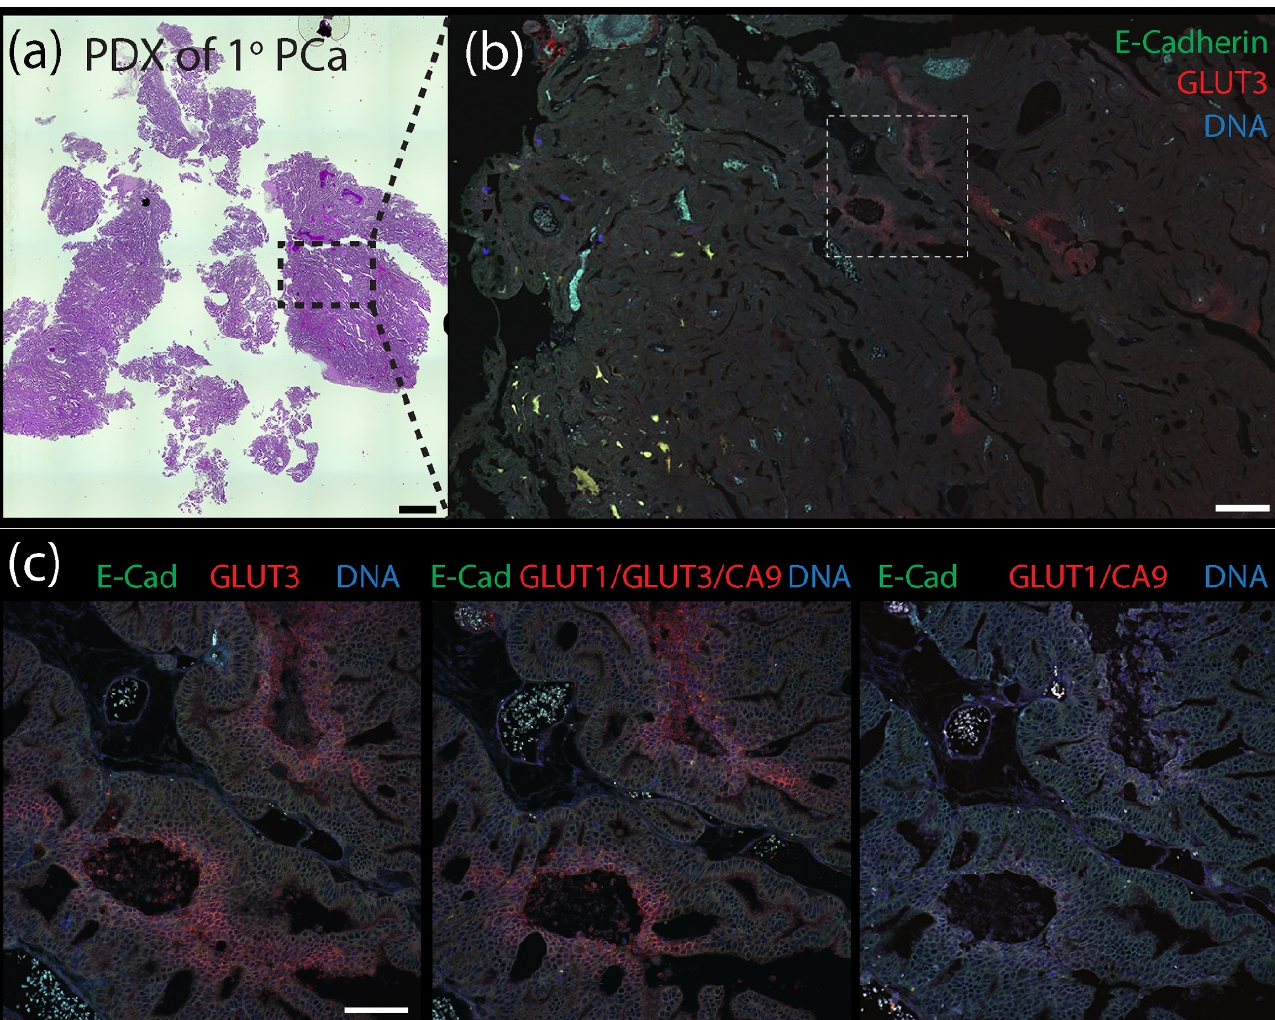
Figure 6. Patient-derived xenograph (PDX) model of primary prostate cancer contains distinct pockets of GLUT3 staining. ( a ) Patient-derived xenograft (PDX) from a primary prostate tumor stained with H&E. Scale, 1.5 mm. ( b ) Section of PDX tumor immunostained for E-Cadherin (green) to mark cell borders and GLUT3 (red). DNA, blue. Boxed region is shown at higher magnification in ( c ). Scale, 250 μ m. ( c ) Serial tissue sections were immunostained for either GLUT3 (red, left panel), a cocktail containing anti-GLUT1 and anti-CA9 antibodes (red, right panel), or antibodies against all three proteins GLUT1, GLUT3, and CA9 (red, middle panel) as indicated. Dashed white boxes show GLUT3 concentrated at the plasma membrane in tumor cells (insets). Scale, 100 μ m.